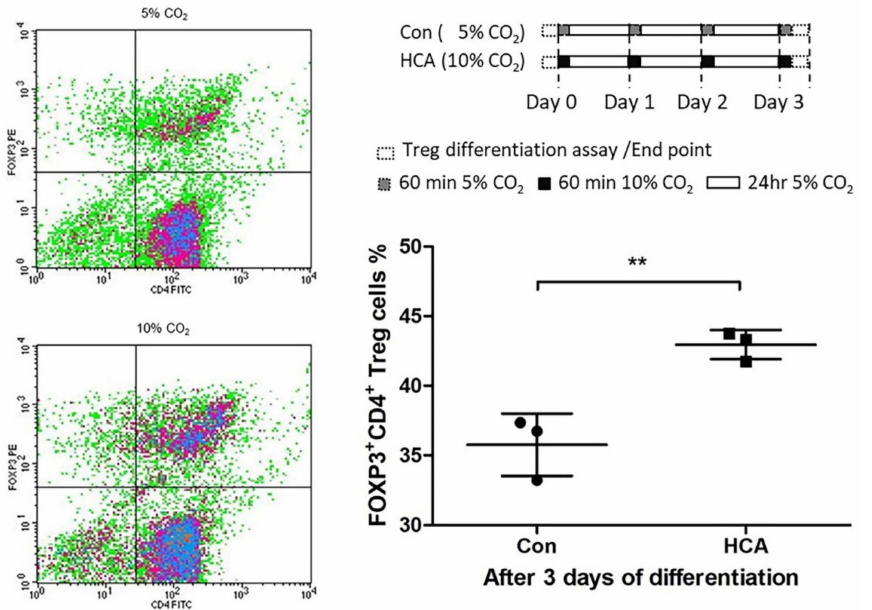
Figure 8. Effect of HCA on de novo generation of Tregs from spleen-isolated naïve CD4 + T cells. Splenic-isolated naïve CD4 + T cells were used for inducing Treg differentiation. After 3 days of culture, the Treg cells’ percentage was analyzed by flow cytometry. Error bars represent the SD from three independent experiments; ** p <